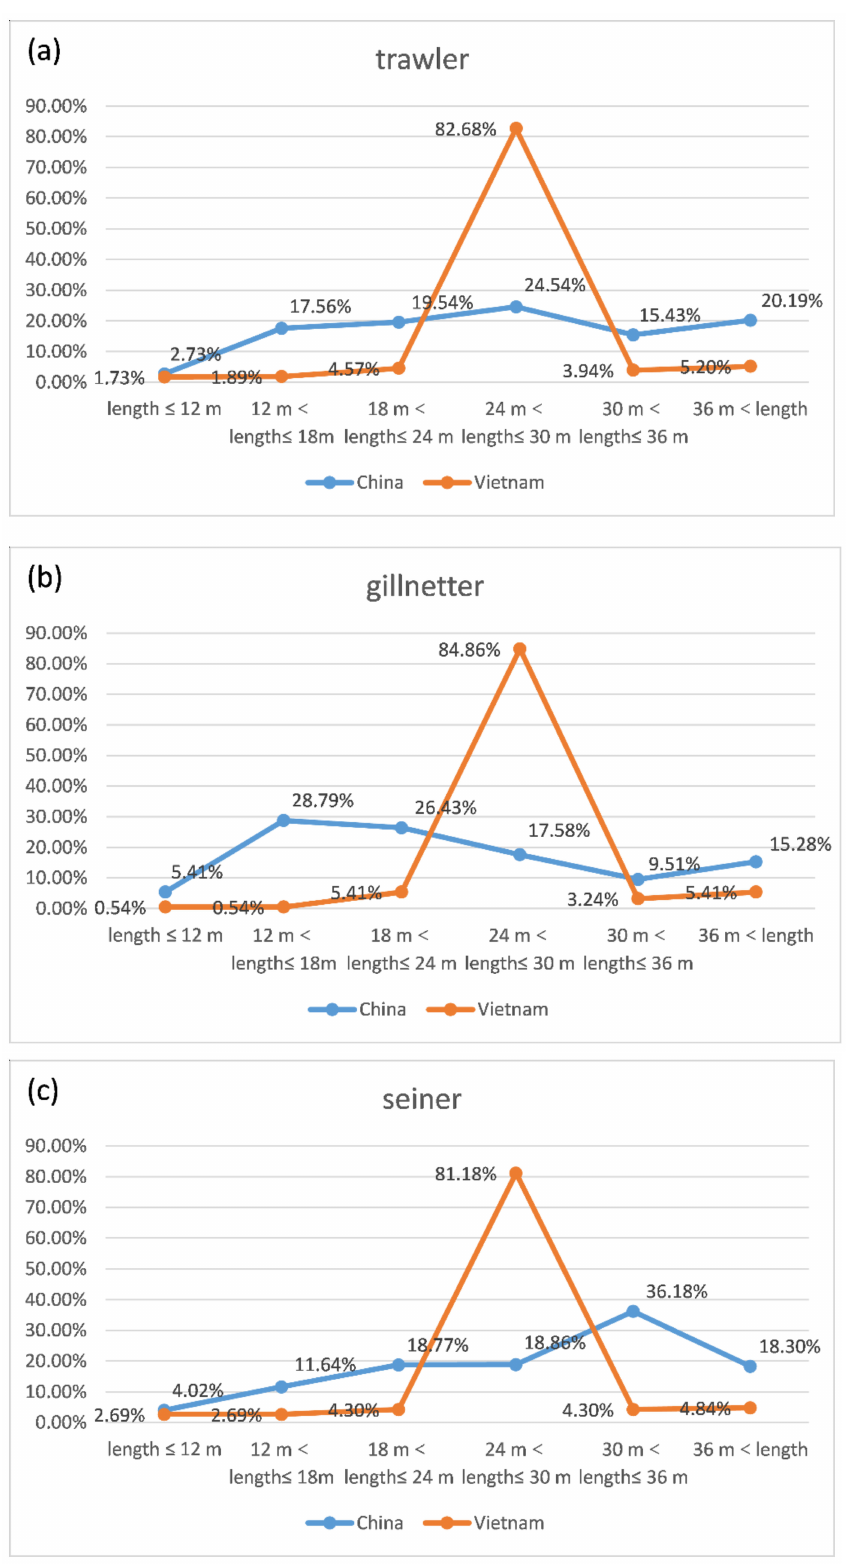
Figure 12. Classification of the length of Chinese and Vietnamese fishing